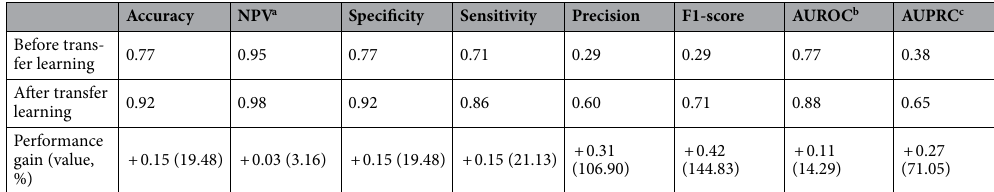
Table 2. Slide-wise performance on the external dataset of the HGH cohort. a Negative predictive value. b The area under the receiver-operating characteristics curve. c The area under the precision-recall curve.